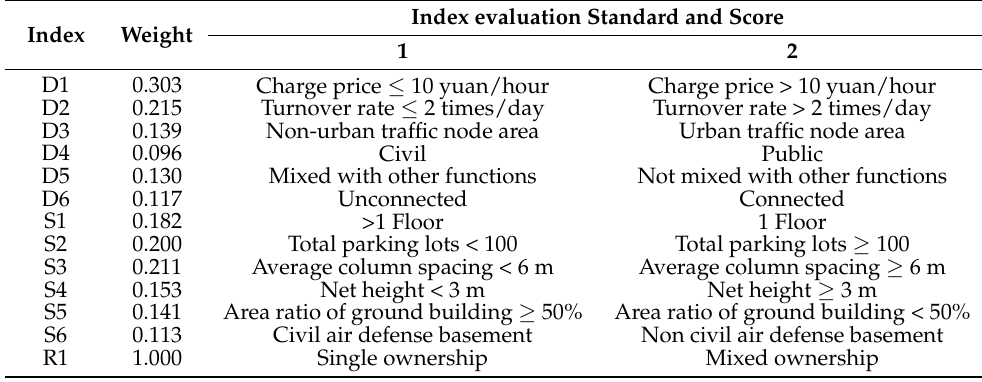
Table 2. Value assignments and weights of the DSR